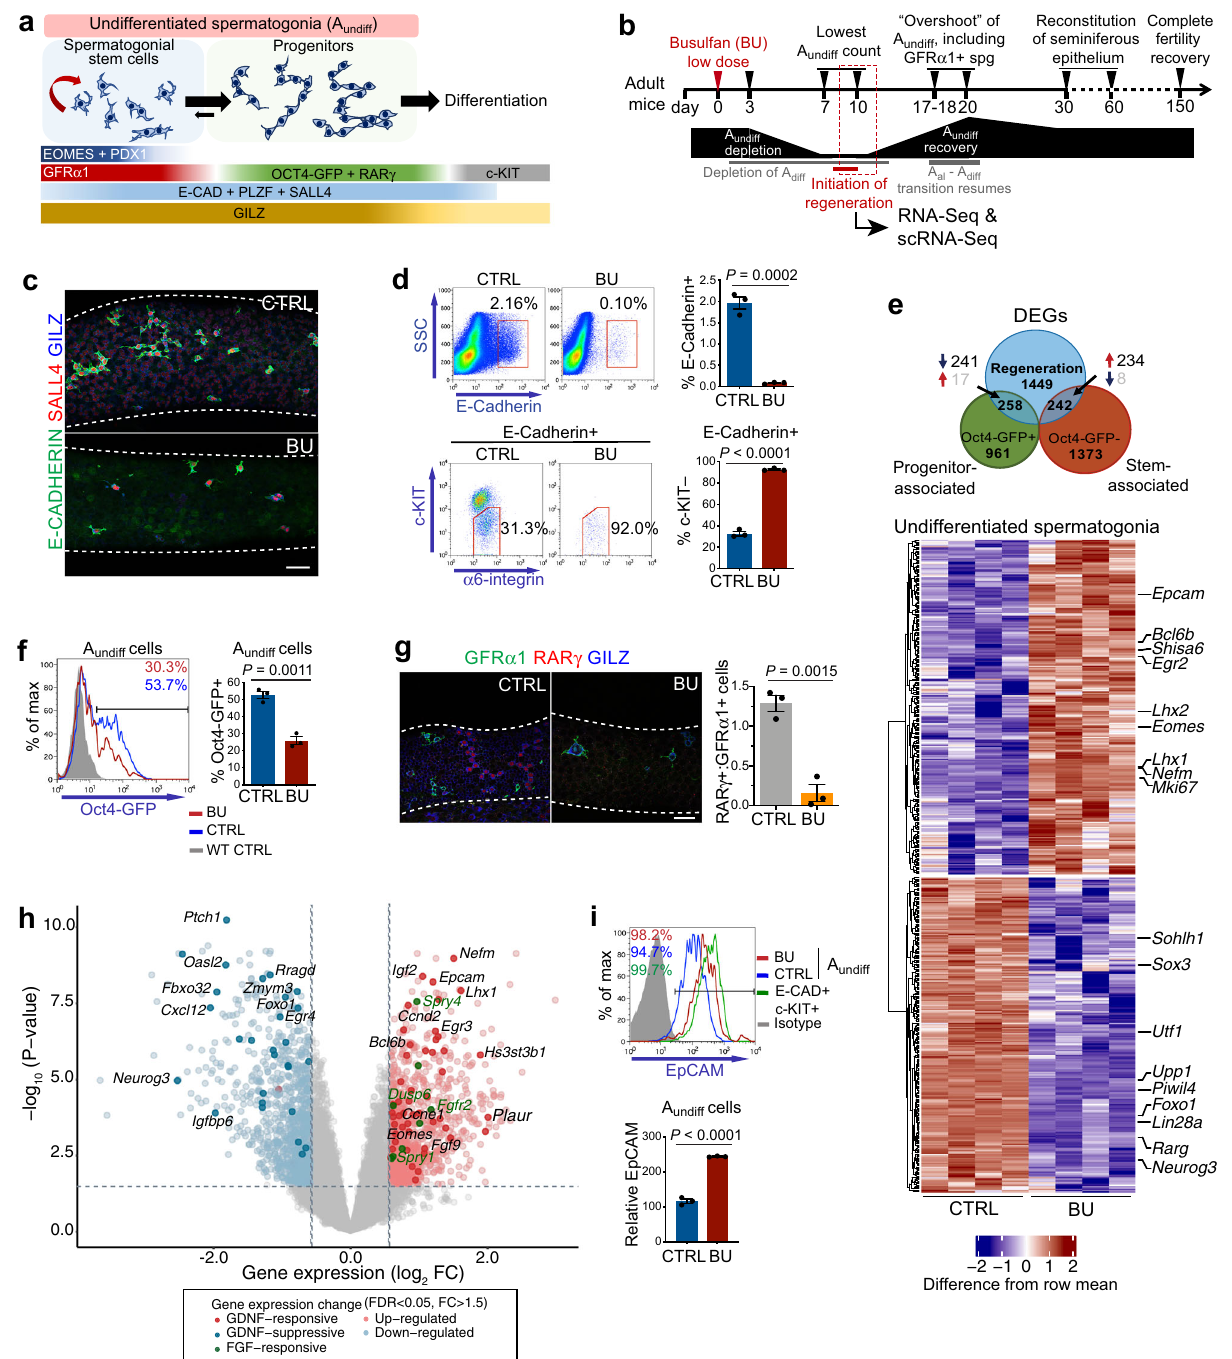
from wild-type control (CTRL) and BU-treated mice at D10 con fi rmed depletion of spermatogonia and persistence of low numbers of E-Cadherin + SALL4 + A undiff (primarily A s and A pr ) (Fig. 1c). A undiff can be identi fi ed according to cell surface mar- kers E-Cadherin + α 6-integrin + c-KIT – while spermatogonia at early differentiation stages co-express E-Cadherin and c-KIT 24 . By fl ow cytometry, few E-Cadherin + spermatogonia remained and numbers of identi fi ed A undiff were signi fi cantly reduced at D10 after BU compared to controls, con fi rming spermatogonial depletion (Fig. 1d and Supplementary Fig. 1a). >90% of E-Cad- herin + cells were c-KIT – in BU-treated samples versus ~30% in NATURE COMMUNICATIONS| (2022) 13:2500